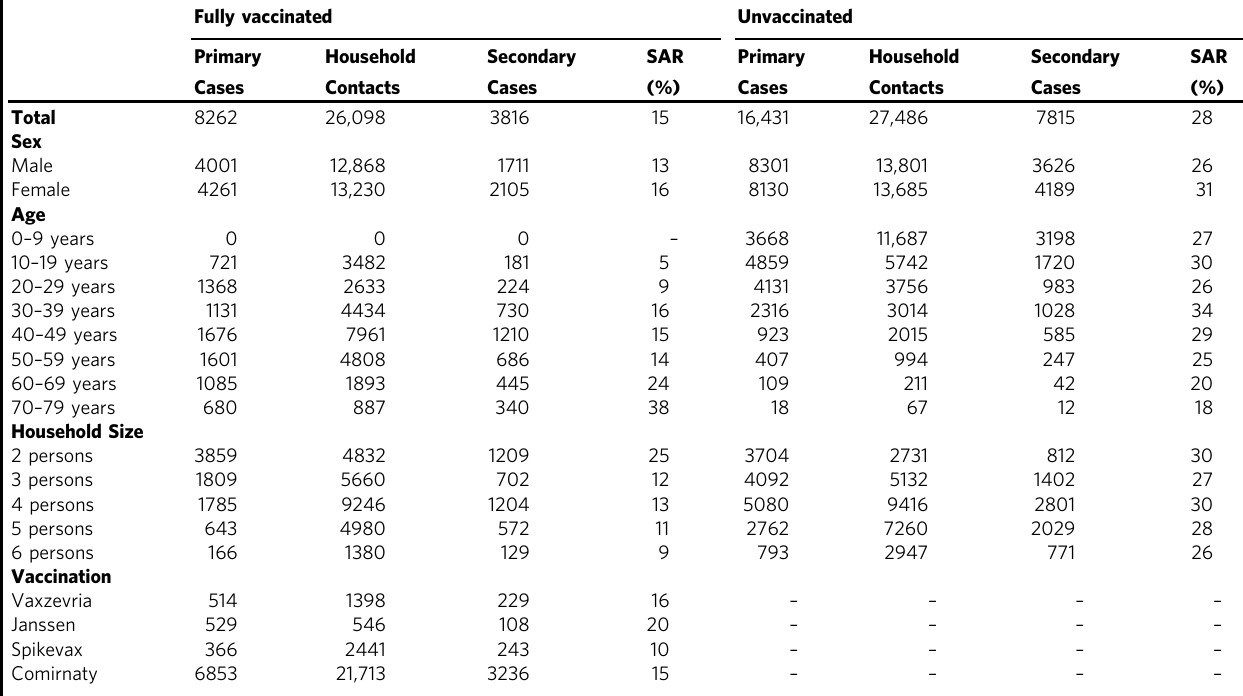
Table 1 Summary